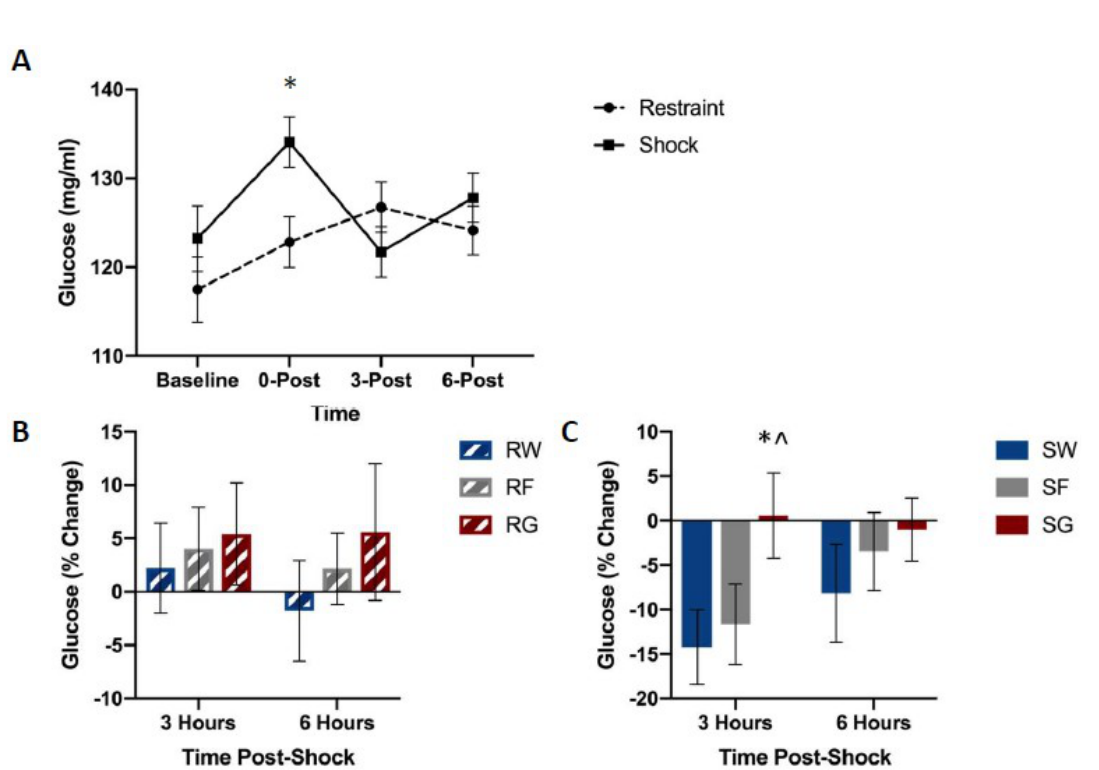
Figure 6. Blood glucose levels between stress treatments (panel A ), and percent change from 0 h post-stress among solution conditions in restraint (panel B ) or shock (panel C ) stress treatments. Blood was collected for analysis before the acute stress session, and 0, 3, and 6 h following the acute stress session. Animals received either inescapable and unpredictable shock (S) or simple restraint (R). Following the stress session, animals were given 18-h free access to a 40% glucose cocktail (G), 40% fructose cocktail (F), or water (W). Glucose mitigated the post-stress decline in blood glucose concentrations in shocked animals. Error bars denote mean ± SEM. * p < 0.05 (comparison for top figure: Restraint, Shock, comparison for bottom figures: SG, SW), ^ p < 0.05 (comparison: SG, SF).